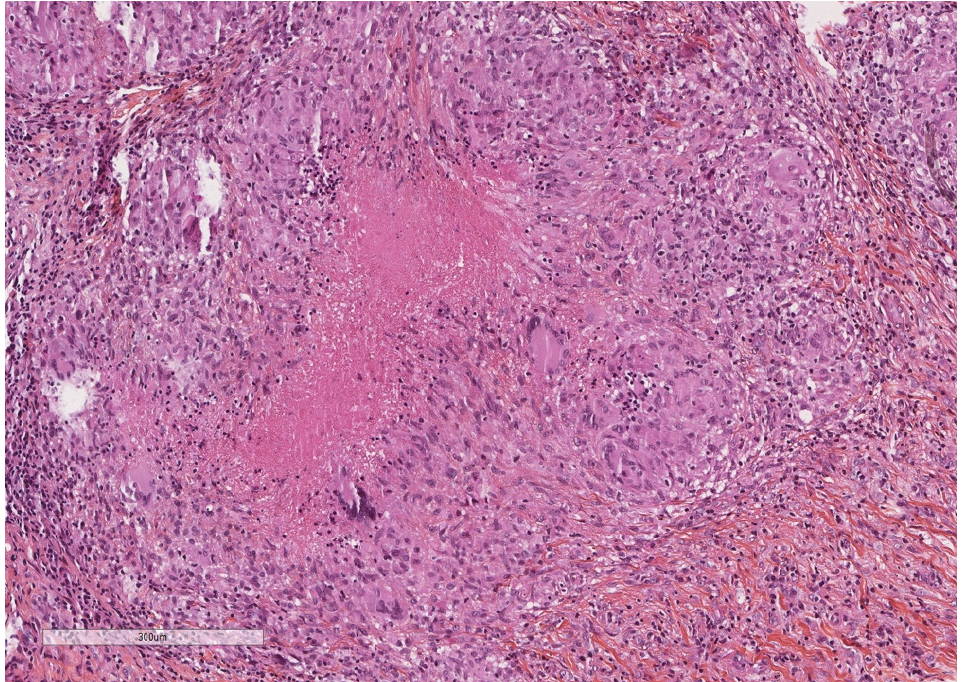
Figure 5. Epithelioid granulomas with giant cells and central necrosis characterize this pleural tuberculosis. Hematoxylin, eosin, saffron staining (×400).